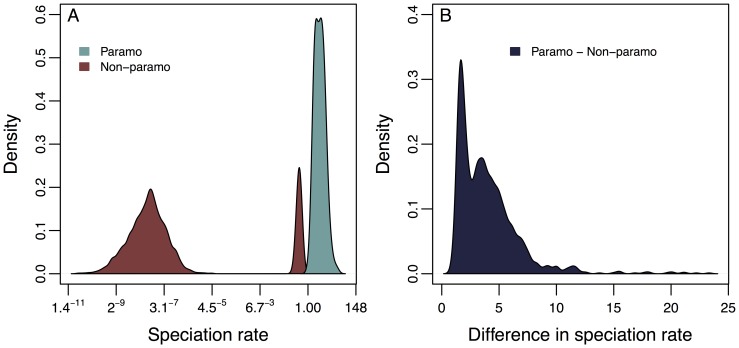
Probability densities of speciation rate estimates for the best fitting BiSSE model.Probability densities are based on the maximum likelihood parameter estimates on each of 1000 alternative phylogenies. Panel (a) shows estimates of speciation rate for páramo and non-páramo species. Extinction and transition rates do not differ in the best-fit model. Panel (b) shows the difference in speciation rates between páramo and non-páramo species plotted as páramo speciation rate – non-páramo speciation rate.